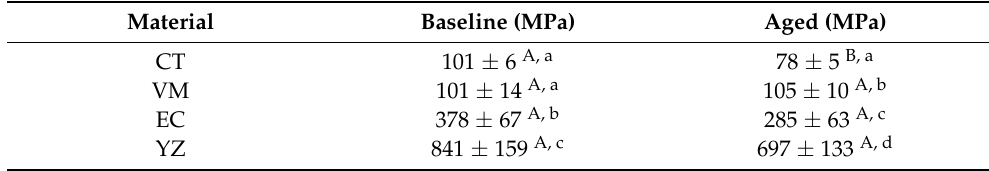
Table 5. Flexural strength mean values and standard deviations. Statistically significant differences between groups determined with Fisher-LSD post-hoc test indicated with varying superscript letters ( p > 0.05) (upper case horizontal, lower case vertical).